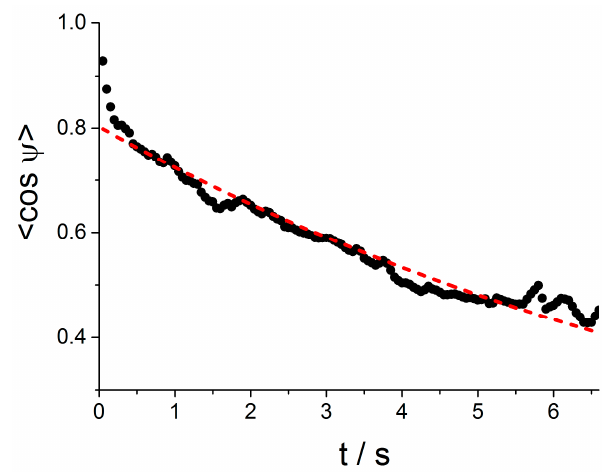
Figure 6. Temporal evolution of the mean square displacement of the center-of-mass of a microgel chain. Blue line: linear fit. Inset: single track of the center-of-mass.